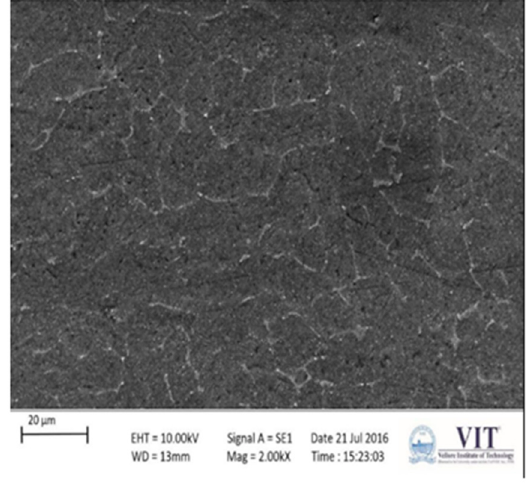
Figure 2. SEM image of Al6061 alloy.